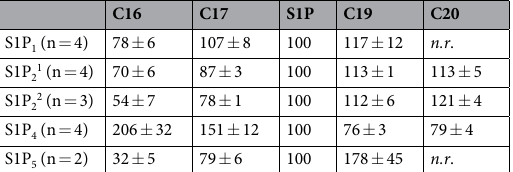
Table 1. E max values of S1P derivatives at S1P receptors. The maximal efficacy for each compound at each S1P subtype was determined from the dose-response curves of the aequorin-based functional assay. Mean values on 2 to 4 independent experiments are normalized on S1P maximal response and expressed in %, along with the corresponding S.E.M. values. 1 S1P 5 cells, 2 CHO-Aeq cells, n.r . = not reliable.